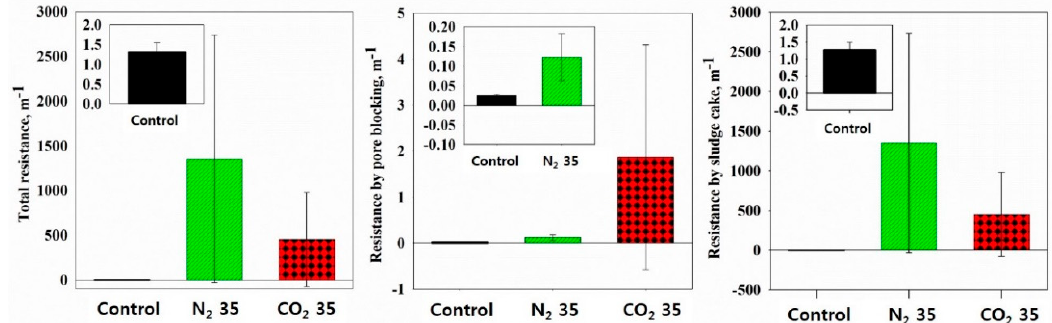
Figure 12. Total resistance, resistance by sludge cake, and pore